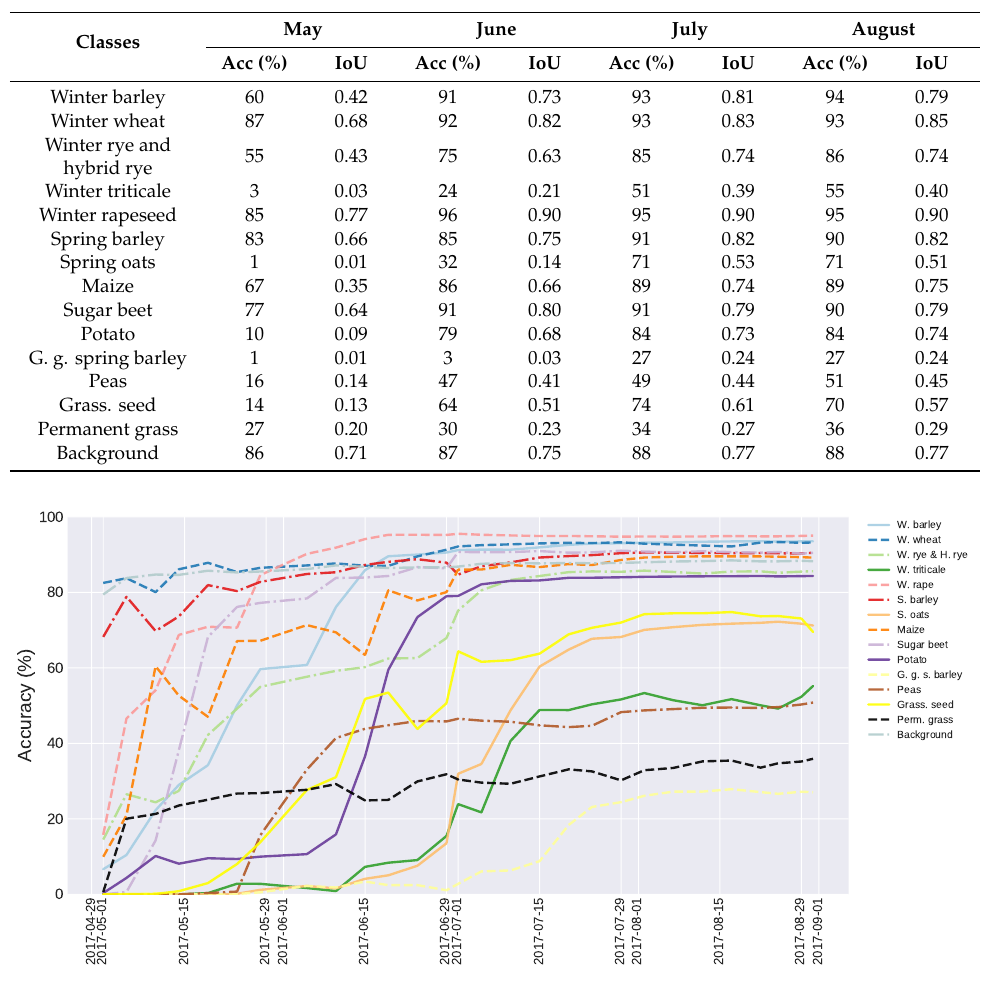
Figure 8. The pixel-based accuracy at di ff erent